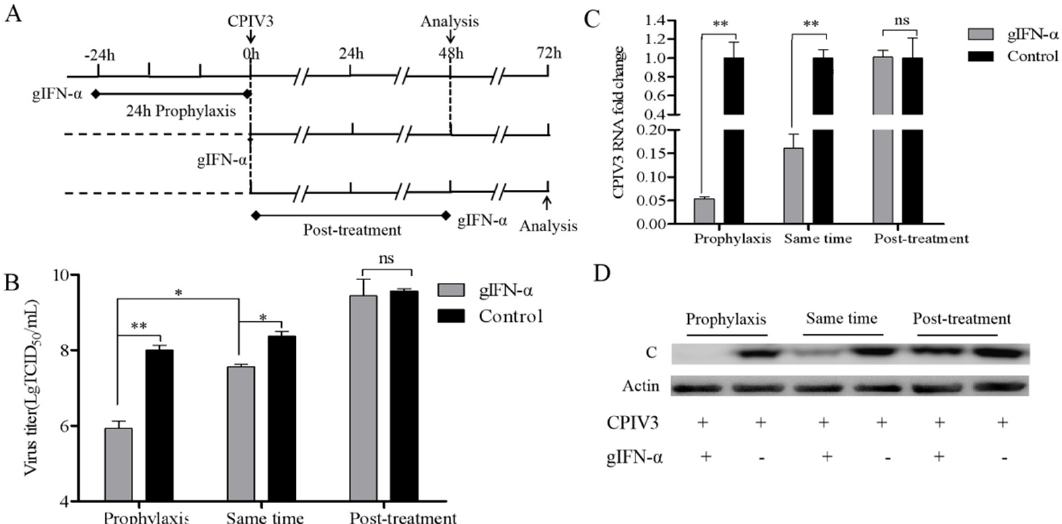
Figure 2. Goat IFN- α prophylaxis but not treatment modulates CPIV3 infection in MDBK cells. ( A ) Experimental schematic. MDBK cells were treated with goat IFN- α (1 µ g/mL) 24 h before infection or together with infection, and then the samples were harvested at 48 hpi. MDBK cells were treated with goat IFN- α (1 µ g/mL) 48 h after infection, and the samples were harvested 24 h later. The MDBK cells were infected with CPIV3 strain JS2013 at an MOI of 1. ( B ) TCID 50 results, detecting the virus titer in the culture supernatant between different groups. ( C ) The viral RNA level enabled quantification of the viral shedding in the culture supernatant by RT-qPCR. ( D ) The expression level of CPIV3 nonstructural protein C was detected by Western blot with the anti-CPIV3 protein C antibody. The untreated cells were used as the negative control. The results were reported based on duplicate independent experiments and compared with the negative control in each group. *, p < 0.05, **, p < 0.01.